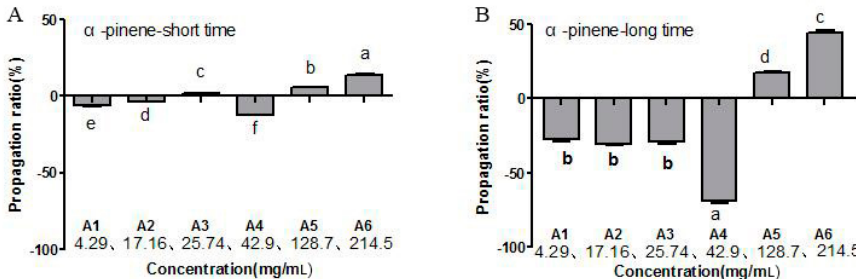
Figure 2. Effect of α -pinene concentration and treatment time on the reproduction rate of PWNs. ( A ) Treatment for a short time. ( B ) Treatment for a long time. There were three biological replications for each experiment. The error line means standard deviation of the mean. Bars with different letters indicate significant differences among the treatments, as defined by Duncan’s test ( p < 0.05).